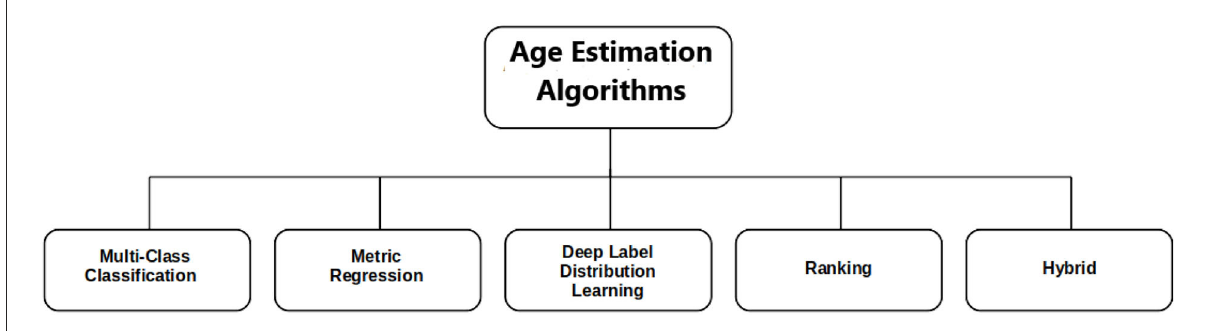
FIGURE2 Classification of apparent age estimation approaches. The typical apparent age estimation methods are categorized into five different